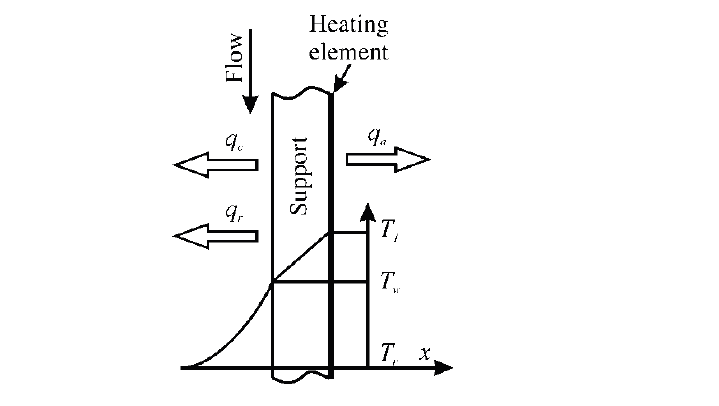
Figure 4. Thin foil heated from the sensor back surface for a relatively high Bi . Adapted from